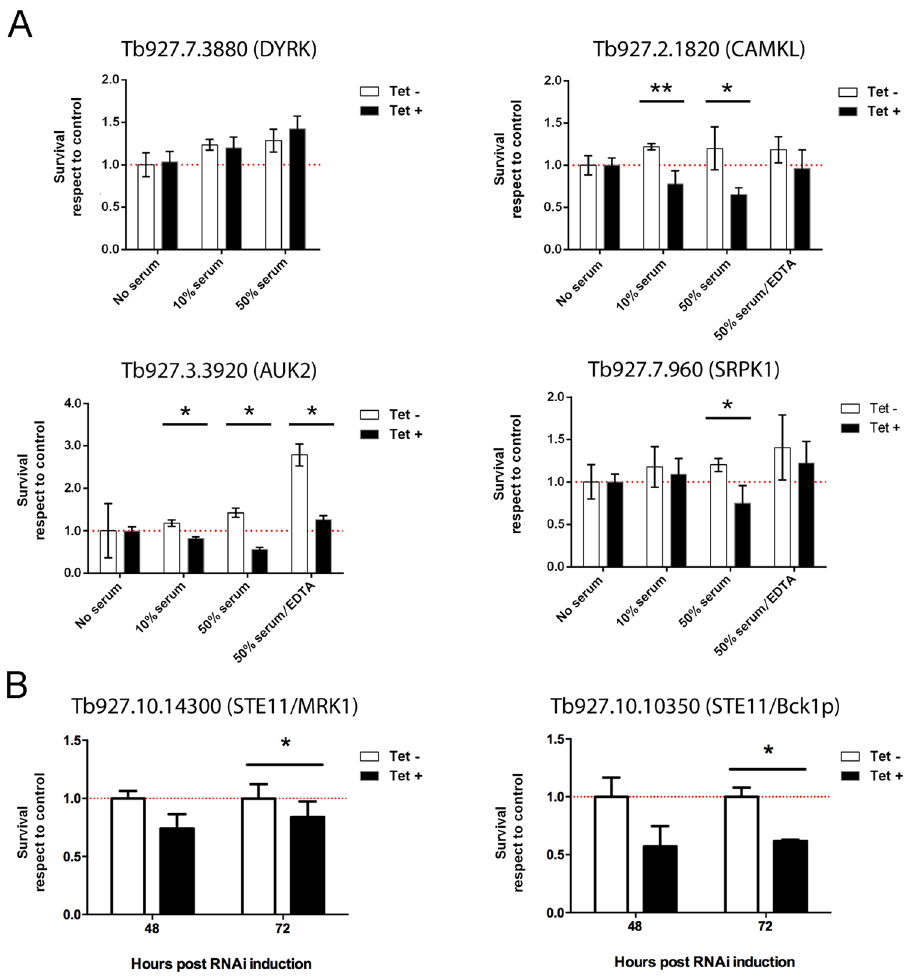
Figure 4. Survival when exposed to serum or osmotic shock. (A ) Parasites at 10 6 cells ml − 1 were exposed for 3 h to rat serum (10% and 50% concentration). Relative survival was measured for induced (tet + , 72 h RNAi) and uninduced (tet − ) clones compared to no-serum controls. Where deficient survival was detected in tet + , after addition of tet, cells were exposed to 50% serum complement-inactivated with 20 mM EDTA. ( B ) Cells were subjected to an osmotic shock protocol and survival of the induced cells (tet + , 48 h and 72 h RNAi) compared to uninduced (tet − ) was plotted. * p < 0.05, using paired